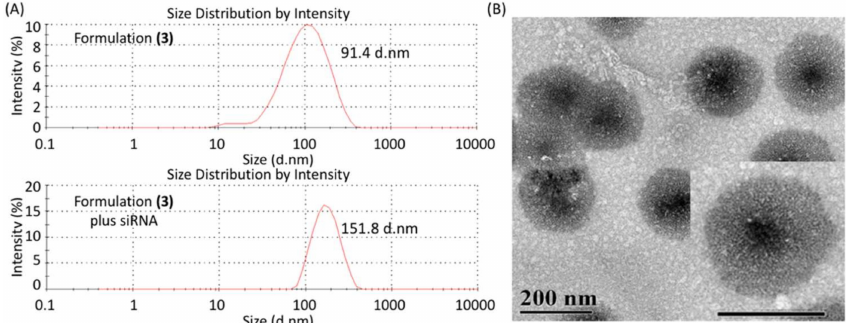
Figure 2. Measurement of the size distribution of Chorn3 LNP (3). ( A ) Size distribution obtained by dynamic light scattering (DLS) before and after complexing with short interfering RNA (siRNA). ( B ) TEM image of Chorn3 LNP (3) complexed to